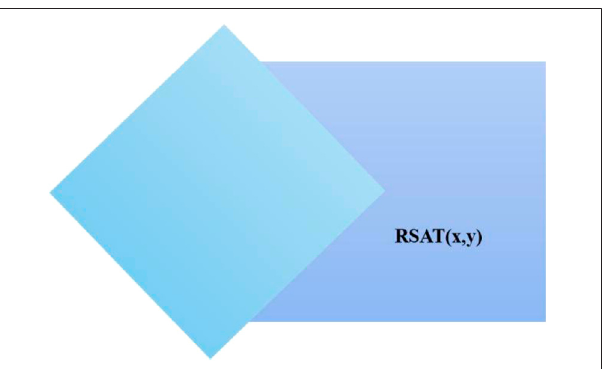
FIGURE 5 | Representation method of the rotation integral